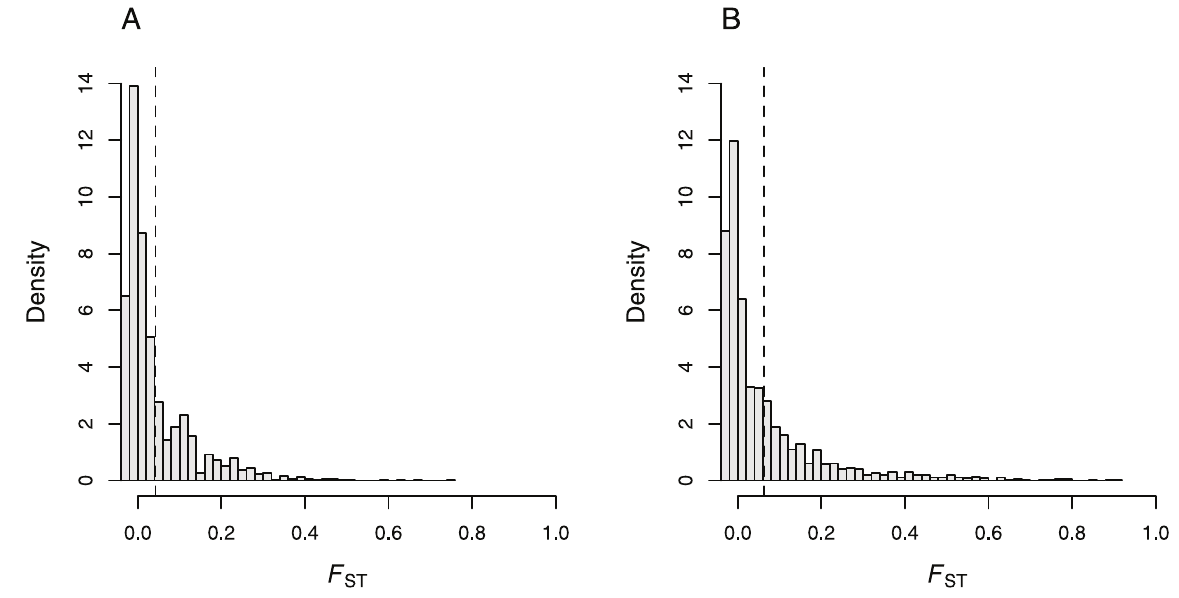
Figure 4. Distributions of F ST estimates between populations sampled on different host plants, across all AFLP markers in France (A, including all pairs of ECB and ABB populations) and in China (B, including all pairs of ACB and ABB populations). Mean values of the distribution are 0.042 and 0.063, respectively, as indicated by the vertical dashed lines. Both distributions are highly leptokurtic (i.e. with kurtosis . 3) and significantly different from one another (Kolmogorov-Smirnov test, D =0.089, P , 10 2 5 ). Higher kurtosis is observed for the ECB/ABB F ST distribution (kurtosis=12.16) than for the ACB/ABB F ST distribution (kurtosis=11.46).